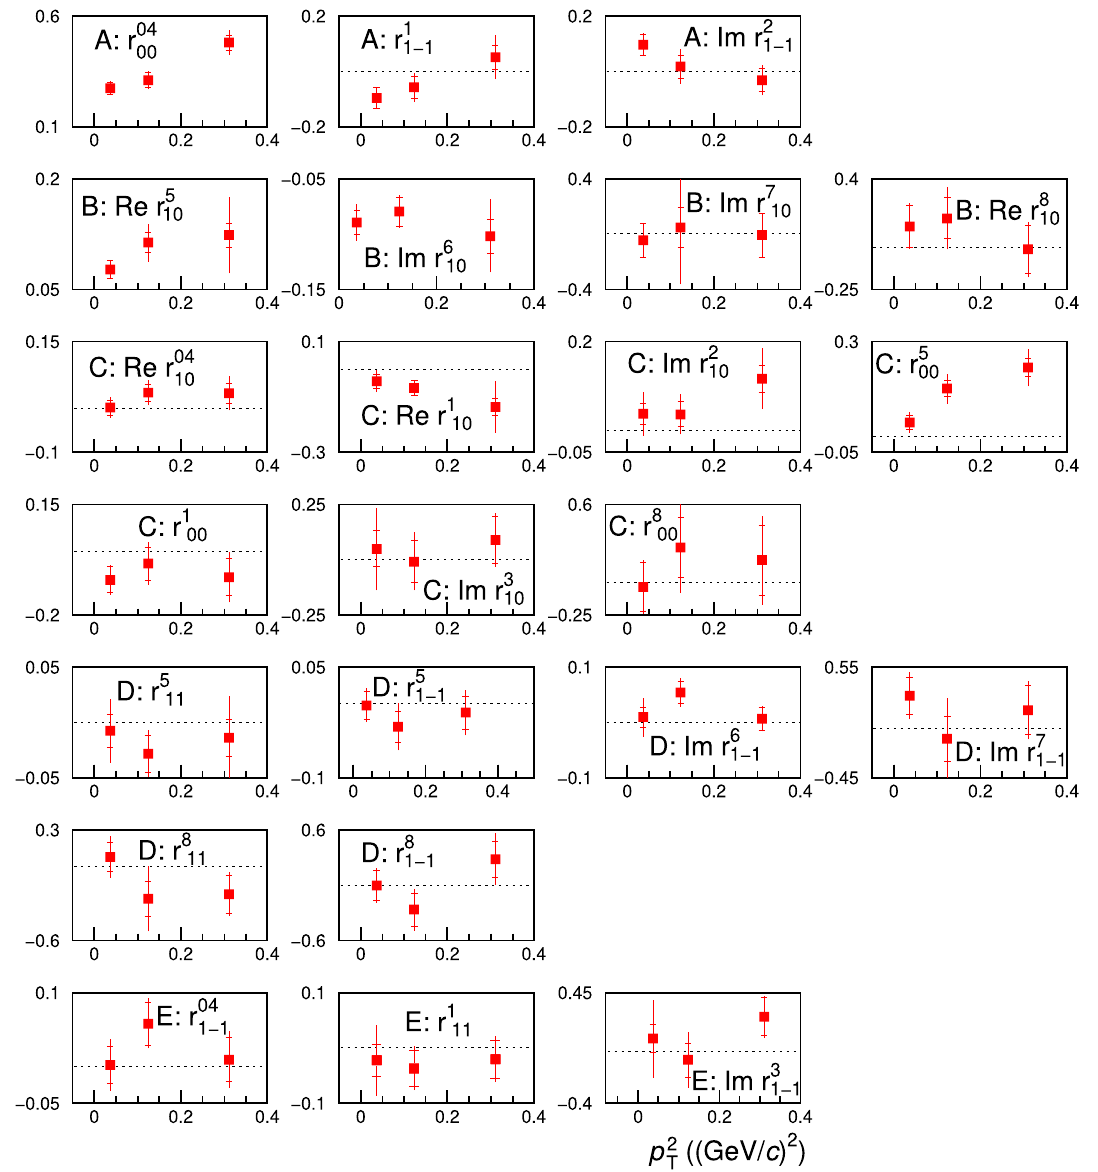
Fig. 7 p 2 dependence of the measured 23 SDMEs. The capital letters A to E denote the class, to which the SDME belongs. Inner error bars T represent statistical uncertainties and outer ones statistical and systematic uncertainties added in quadrature